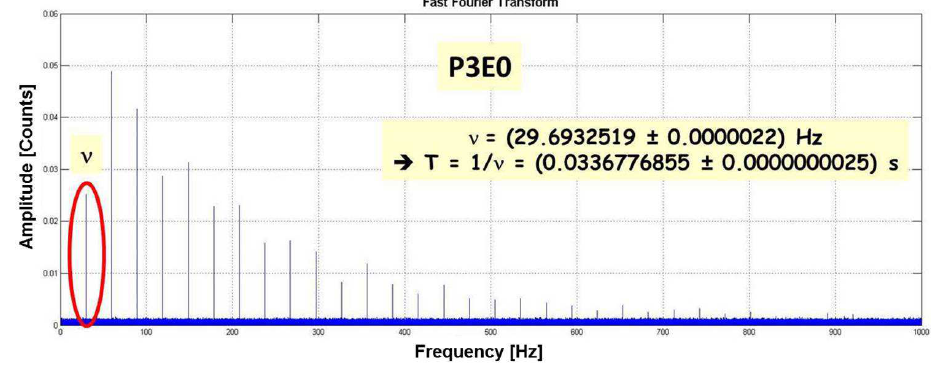
Figure 2: FFT applied to the whole raw data acquired by P3E0 on 2012, December 19.